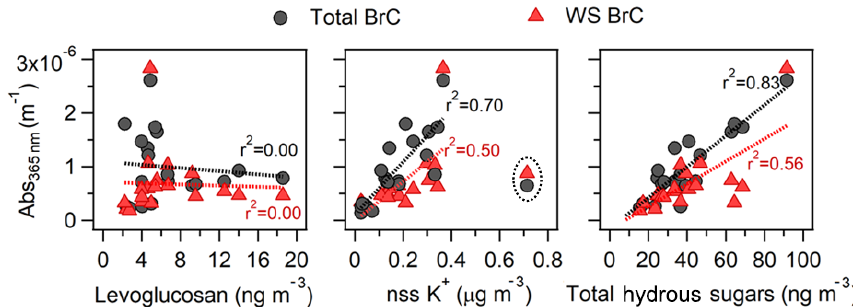
Figure 6. Correlations of light absorption at 365nm for the MeOH (black circles) and water-soluble (red triangles) extractable portion of ambient filter samples that were impacted by biomass burning to biomass burning tracers: (a) levoglucosan, (b) nss K + , and (c) total hydrous sugars. For nss K + , outliers (circled points) were excluded from the linear regression